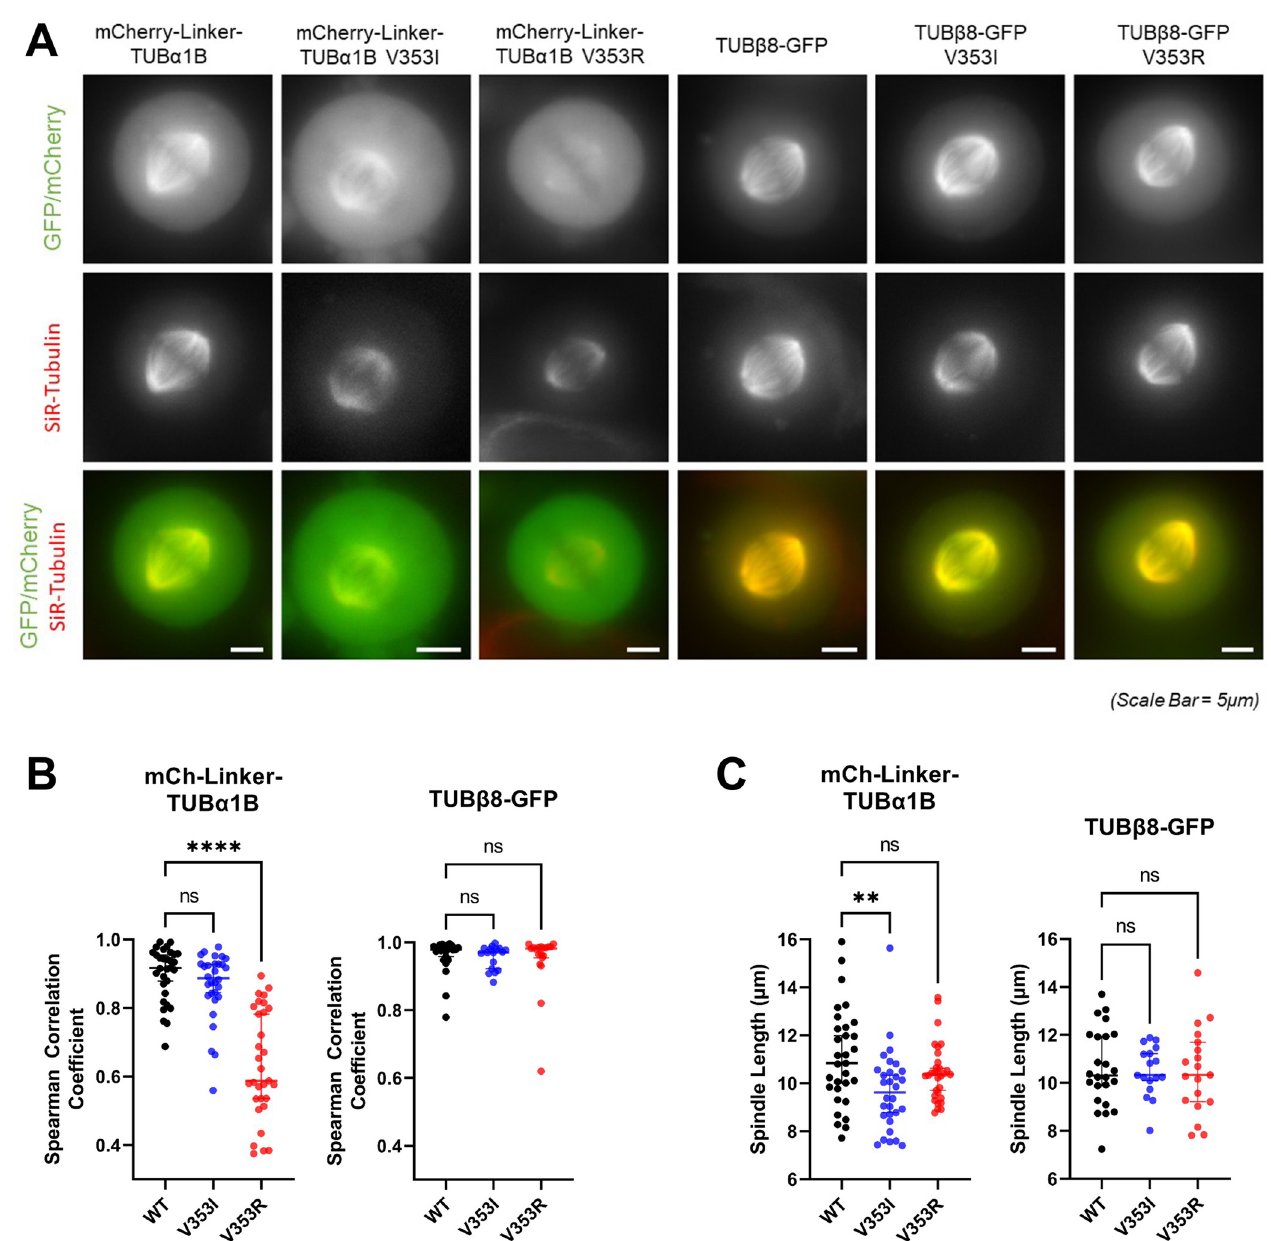
Fig 6. Effects of V353 mutants on microtubules and mitotic spindles in cells. (A) Representative live-cell images of mitotic HeLa cells after being transfected with fluorescently tagged wild type and mutant tubulin- α 1B and tubulin- β 8 constructs (green) and incubated with SiR-tubulin (red) (B) Wide linescans across the whole mitotic spindle were taken to measure fluorescence intensity of tubulin across the mitotic spindle compared to total tubulin. For each cell, two-sided Spearman correlations were calculated between both signal intensities. (C) Spindle length measurements for the cells transfected with fluorescently tagged wild-type and mutant tubulin- α 1B and tubulin- β 8 and measured in (B). For each construct, median values are displayed with 95% confidence intervals. Asterisks indicate Kruskal-Wallis test (with post-hoc Dunn) significance values, ��� , P < 0.001; ���� , P < 0.0001. Bars, 5 μ